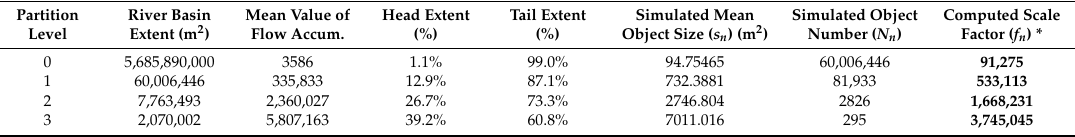
Table 8. Partial and final outputs for flow accumulation in the Acheloos river basin; 0-partition level corresponds to the original flow accumulation